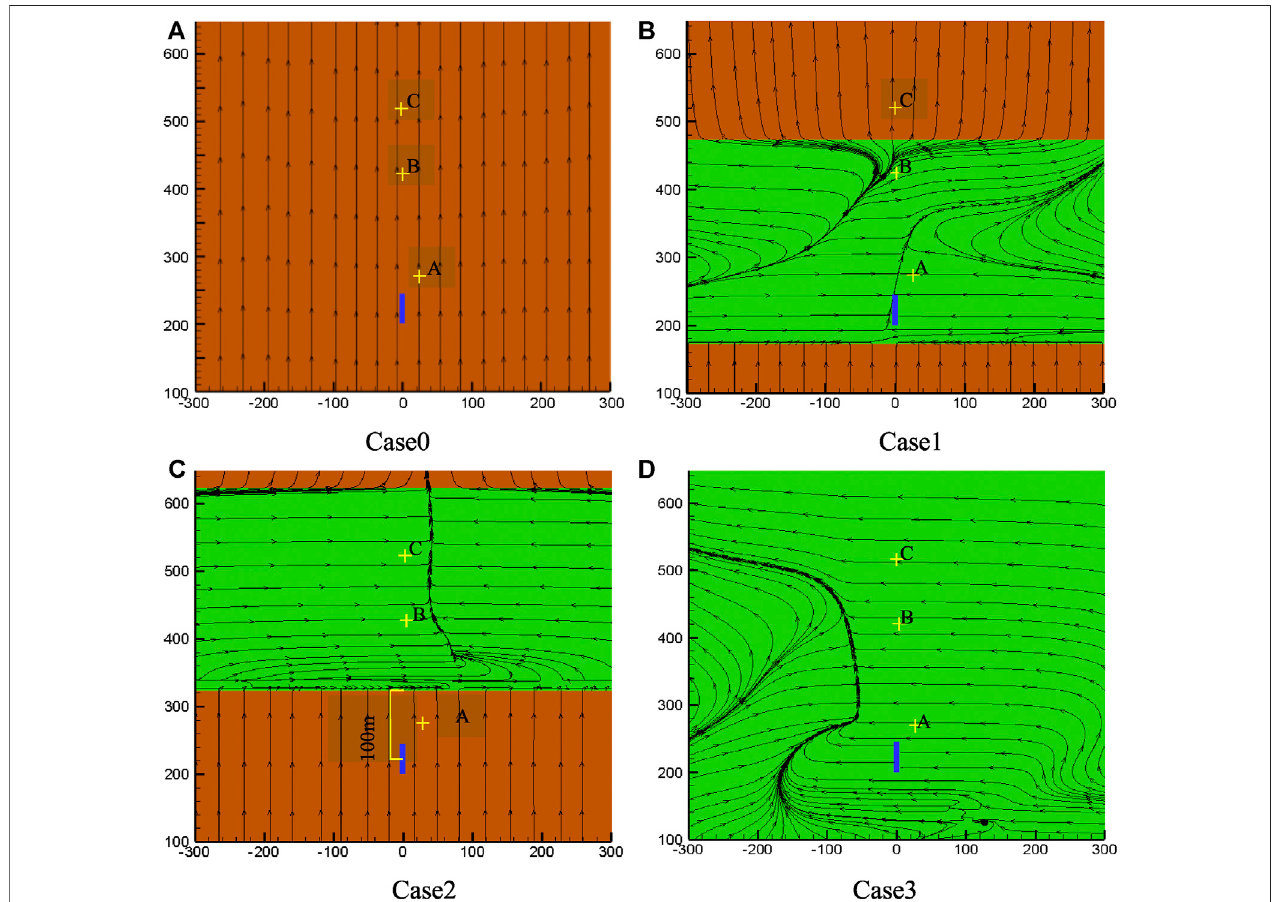
FIGURE 3 | Top view of the initial fl ow fi eld created in the shrubbery for three different cases.